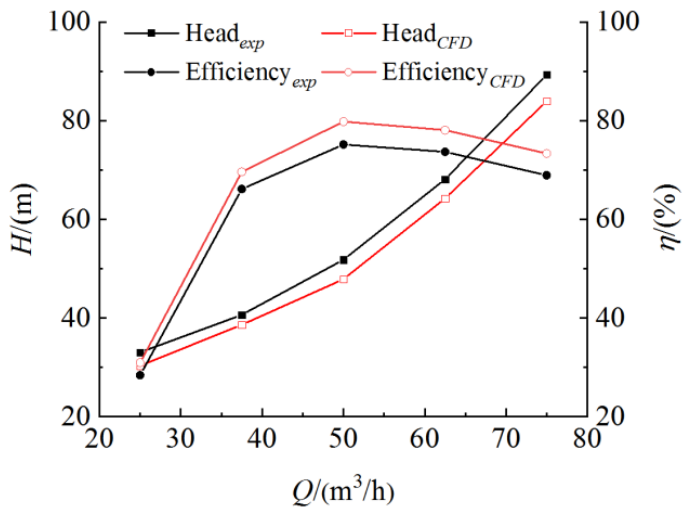
Figure 7. The comparison of PAT performance starting period by simulation and experiment (the left y axis represents head and the right y axis represents efficiency).